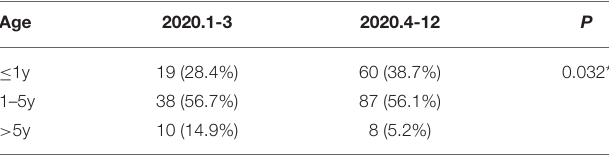
TABLE 7 | The comparision between different